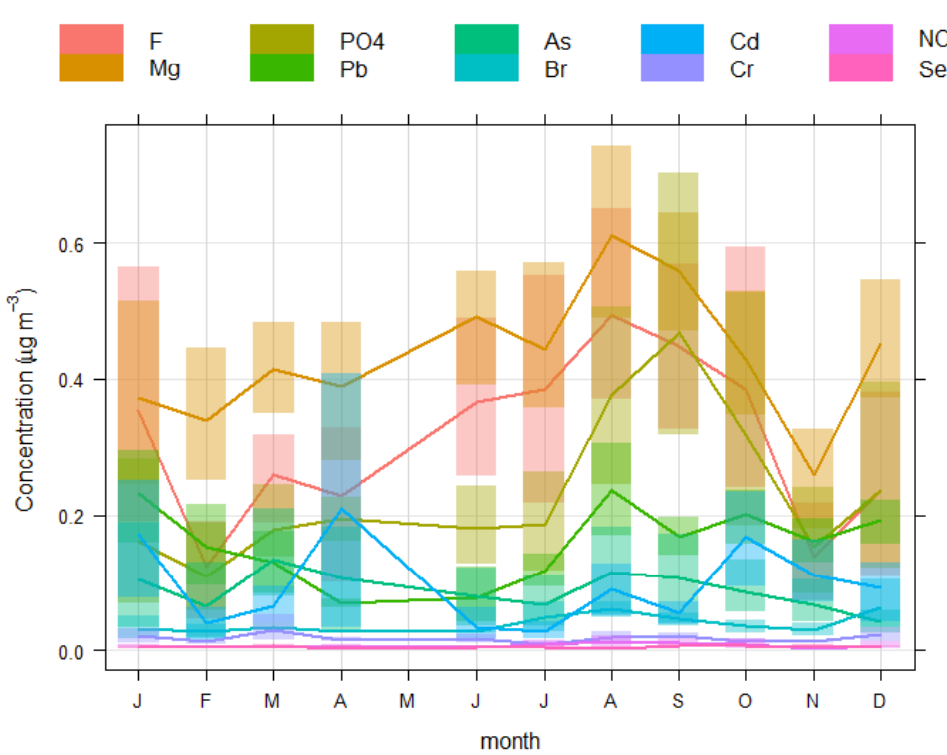
Figure 3. Time variations of monthly average PM 10 ( upper-panel ), major constituents ( middle-panel ), and minor constituents ( lower-panel ) during the study period.